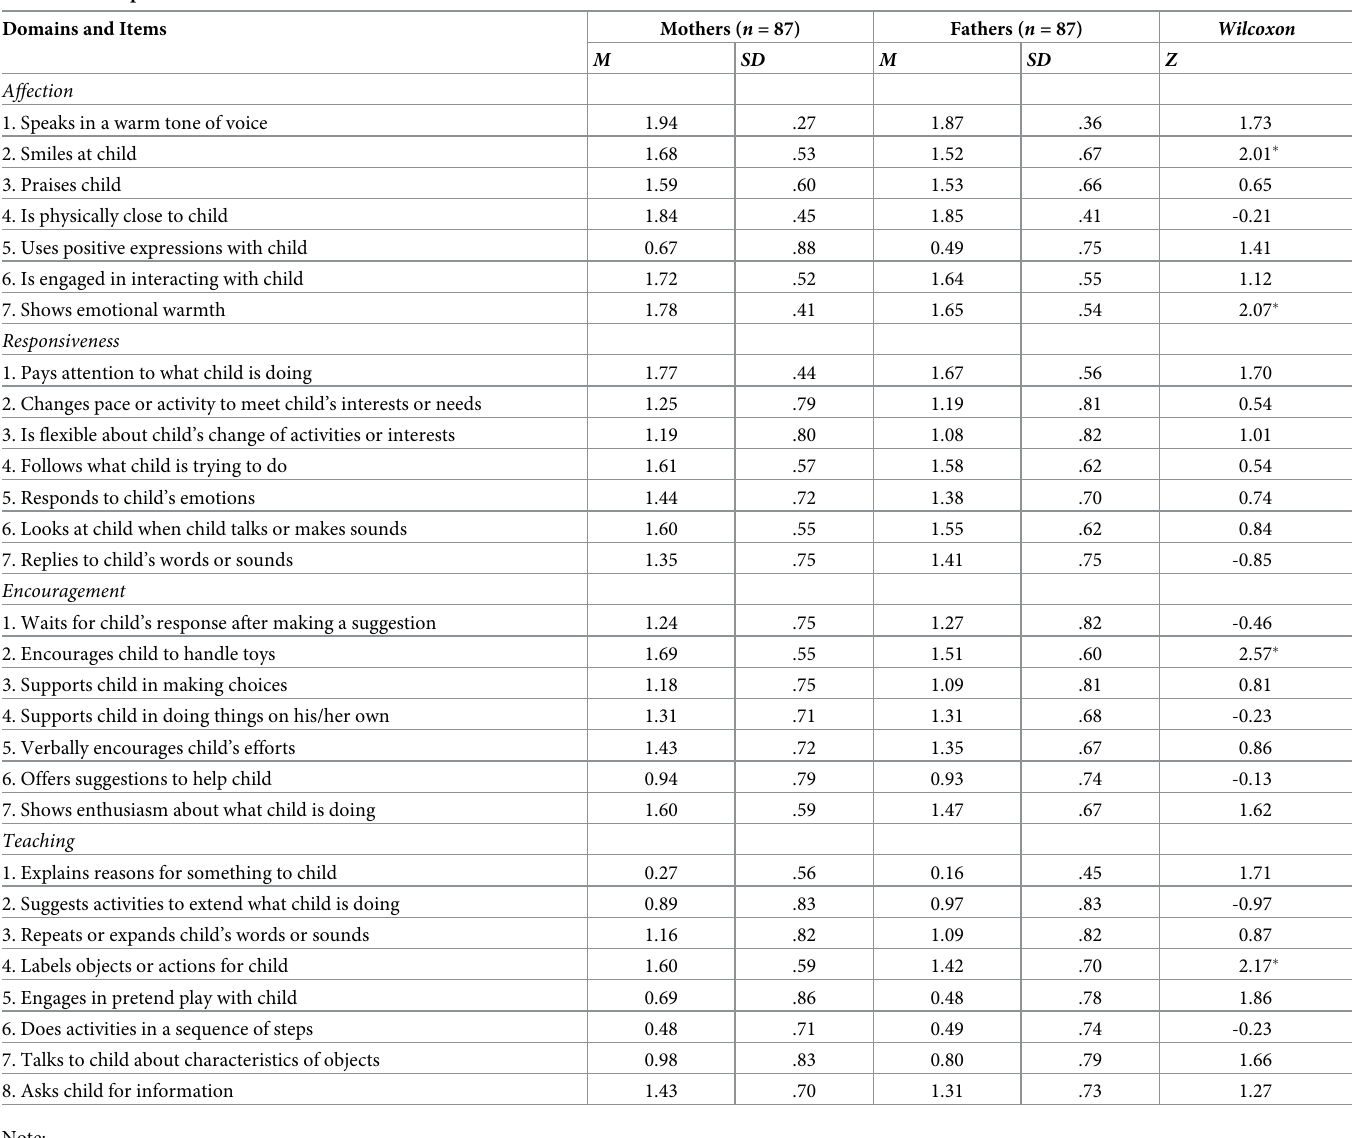
Table 1. Descriptives of PICCOLO item scores for mothers and